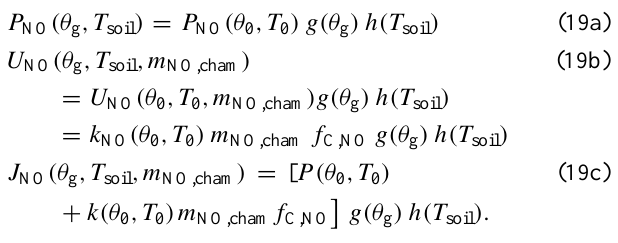
Figure 4. Schematic of NO net release rate ( J NO ) variations, which should be observed under different conditions of gravimetric soil moisture ( θ g ), soil temperature ( T soil ), and the dynamic chamber’s headspace NO mixing ratio ( m NO,cham ). Note, that the shown variations of J NO with T soil are only valid, if Q 10_P,NO = Q 10_k,NO ; then, also Q 10_J,NO = Q 10_P,NO = Q 10_k,NO , see Eq. (3.2)).